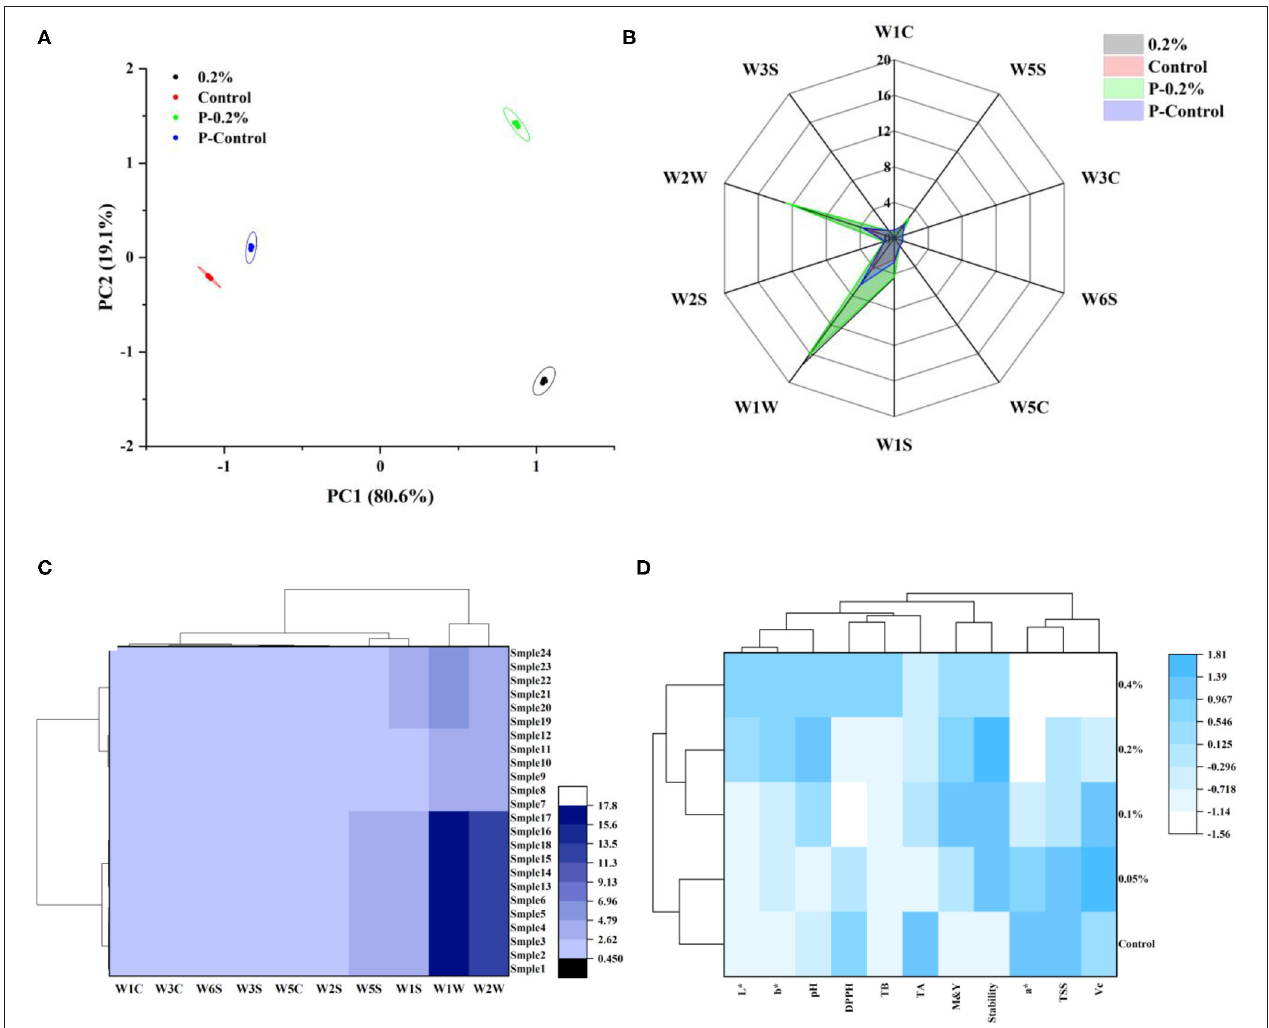
FIGURE 4 | Flavor analysis of four pineapple juices: Principal component analysis (PCA) of volatile flavor by the electronic nose (A) ; radar image of smelling determination by the electronic nose (B) ; hierarchical cluster analysis (HCA) based on flavor (C) . “P-” was the heat treated sample. Heatmap combined with dendrogram of cluster analysis (D) . “TB” was total bacteria count; “M&Y” was molds and